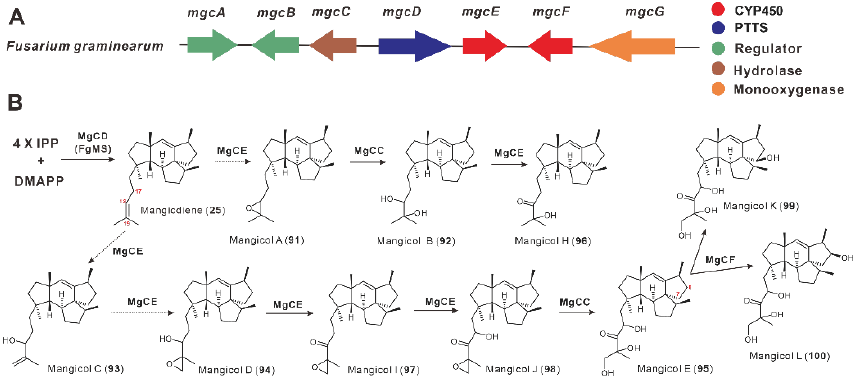
Figure 11. The mgc BGC ( A ) and mangicols biosynthetic pathway ( B ) .